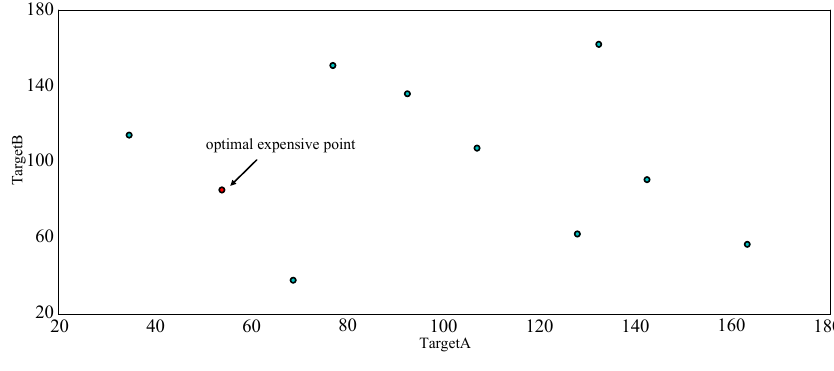
Figure 11. Initial expensive points.